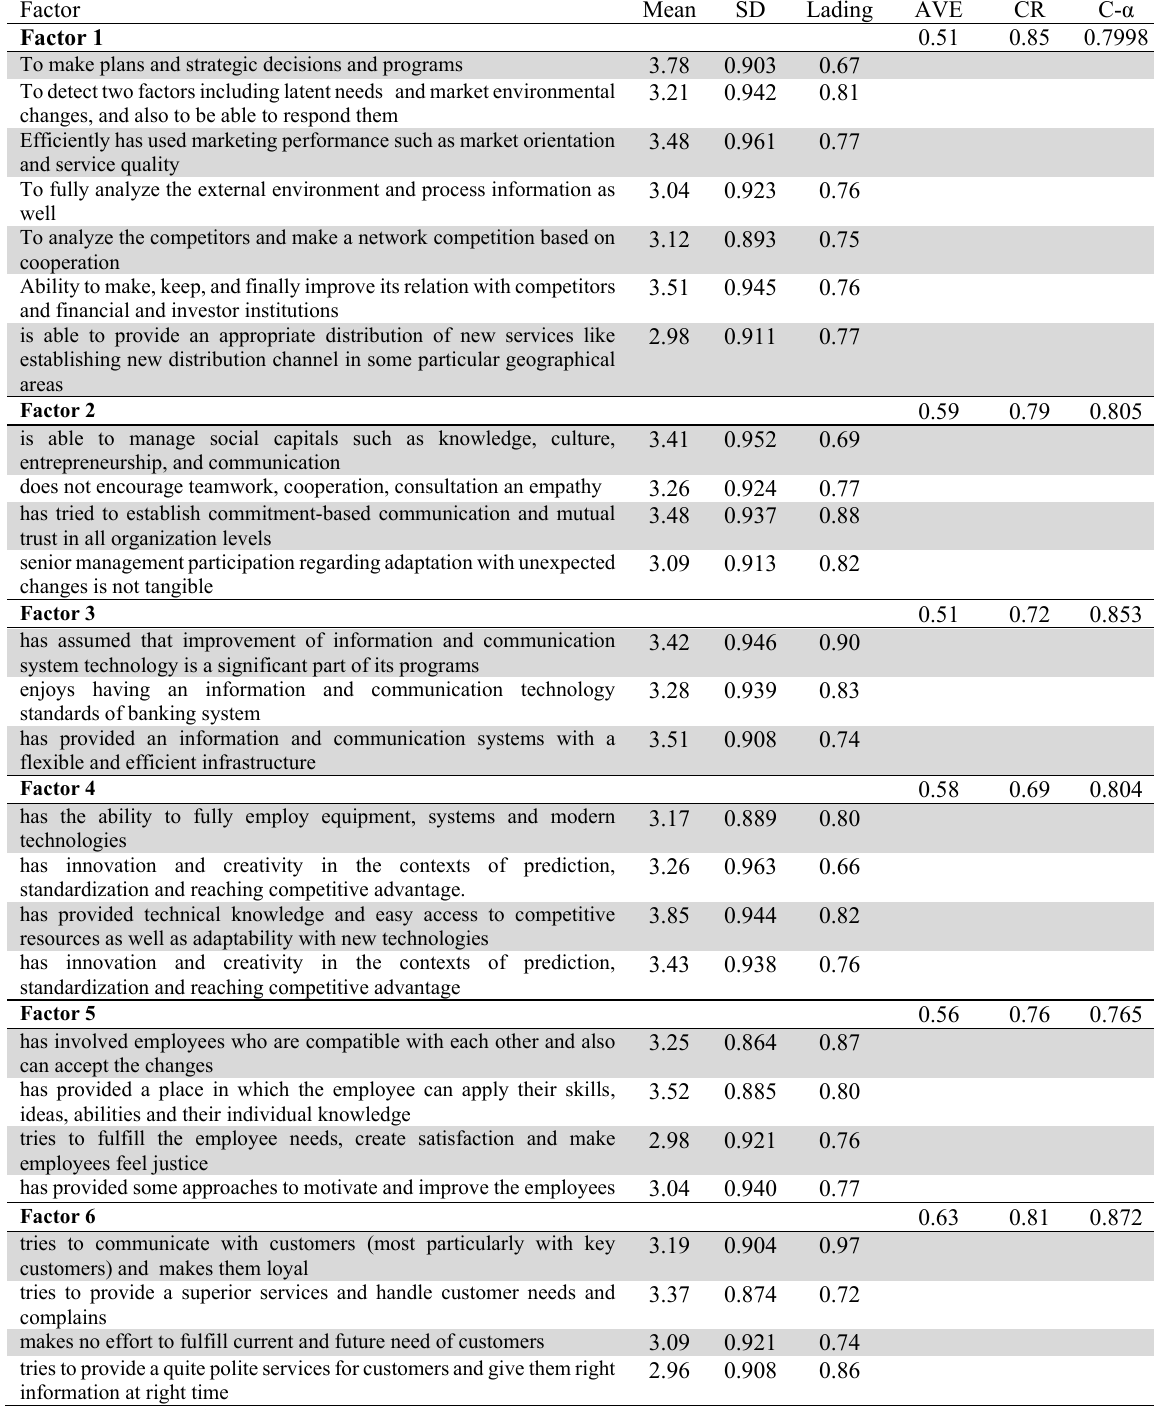
Results of CFA and internal reliability testing & K–M–O